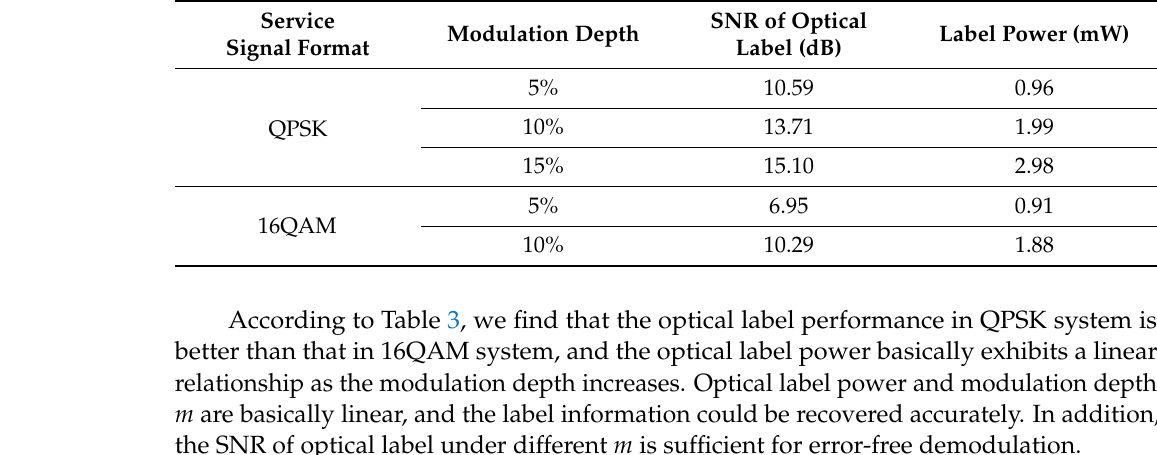
Table 3. SNR and power of optical labels in with different modulate